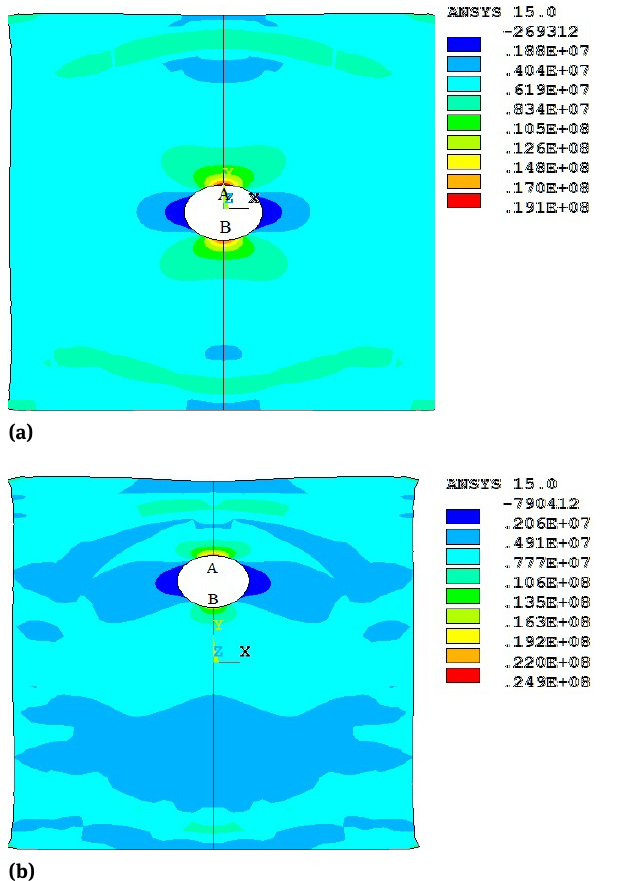
Figure 10: Stress distribution ( 𝜎 𝑥 ) around hole for a normalized eccentricity of (a) zero and (b) 3.0